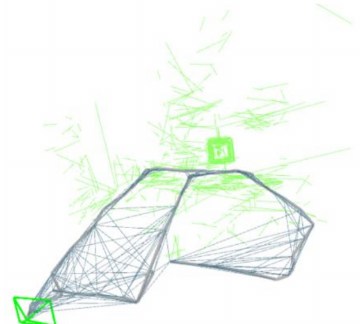
Figure 11. Comparison of the pose measurement experiments with the AR-marker.